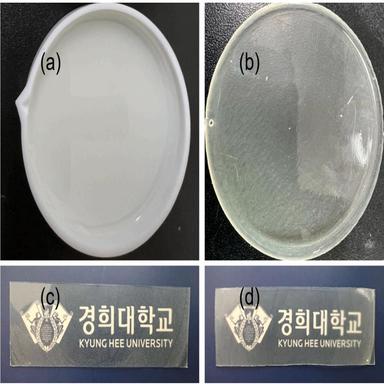
PU solution obtained after polymerization was transferred into PTFE molds for drying (a); PU film after drying (b); petroleum-based neat PU film (c); and biobased PU produced using microbial-derived PHB-diol (right) film (d).